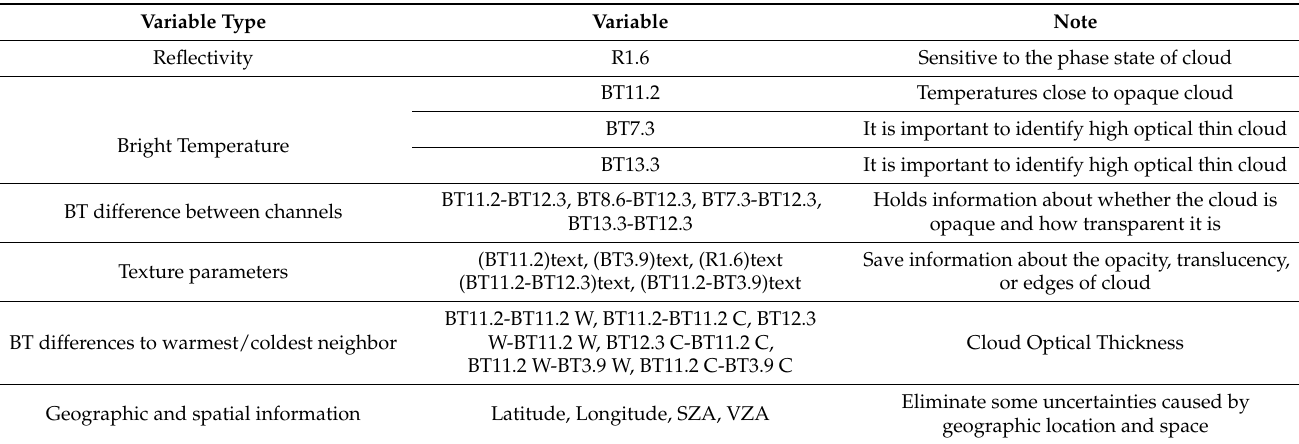
Table 2. Model input parameters.